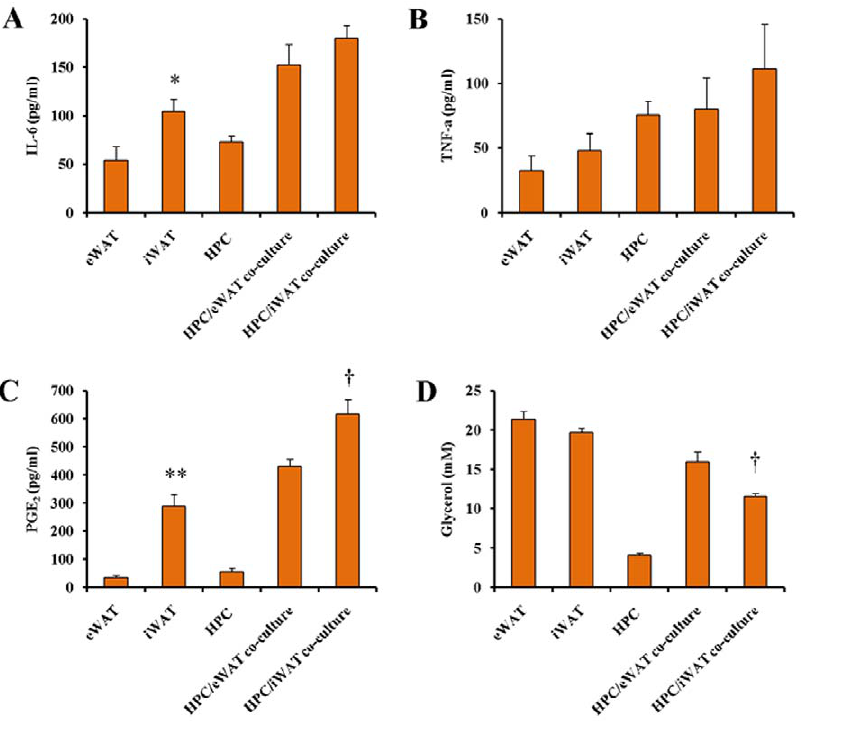
Figure 4. Medium concentration of inflammatory factors in individual and co-culture of rat hepatocytes and adipose tissue explants after 24 h. As described in the Material and Methods section, rat hapatocytes were co-cultured with 20 mg of adipose tissue explants (10 mg 6 2 pieces) from rat epididymal adipose tissue (eWAT) or inguinal adipose tissue (iWAT) in 4 ml DMEM medium and cultured at 37 u C. The individual culture of explants of eWAT, iWAT and hepatocytes were also performed. After 24 h, the medium concentrations of IL-6 (A), TNF- a (B), PEG 2 (C) and glycerol (D) were measured. * and **, P , 0.05 and P , 0.01 vs eWAT group value, respectively. { , P , 0.05 vs eWAT co-culture group value.